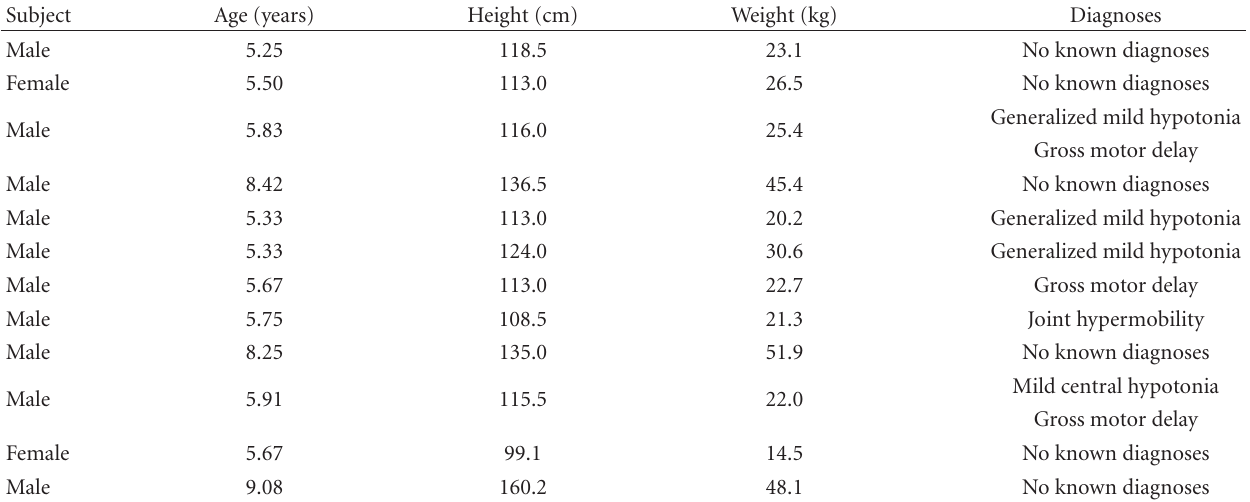
Table 1: Participant characteristics for the autism